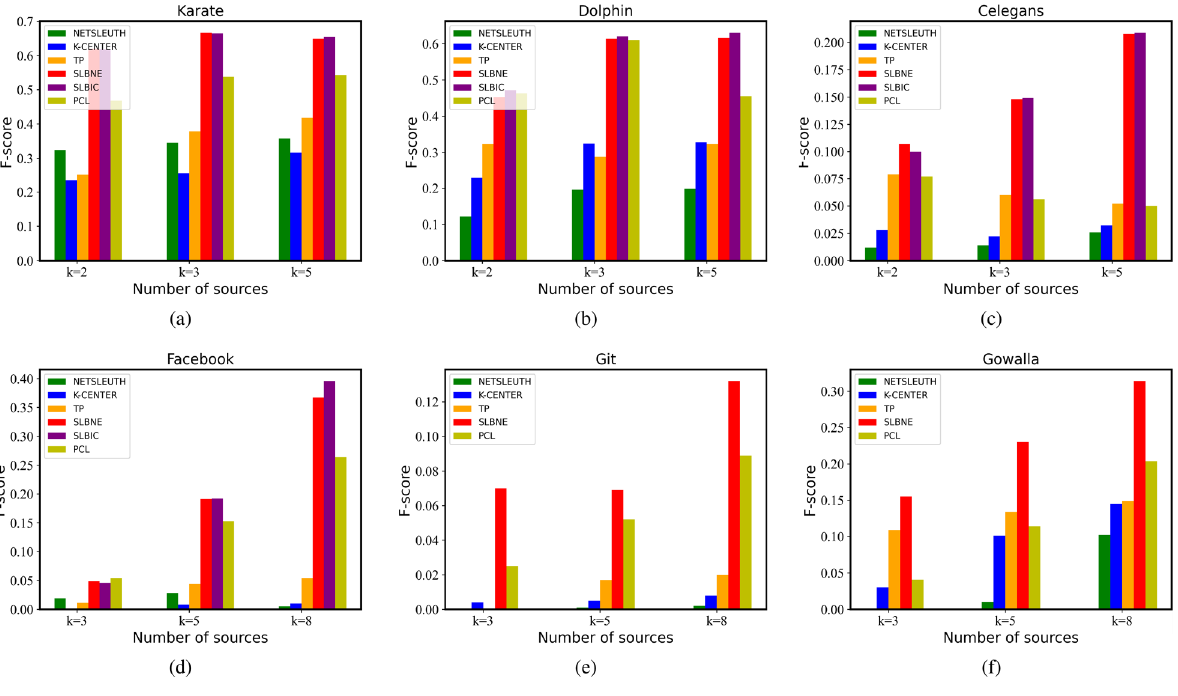
Figure 2. Source location